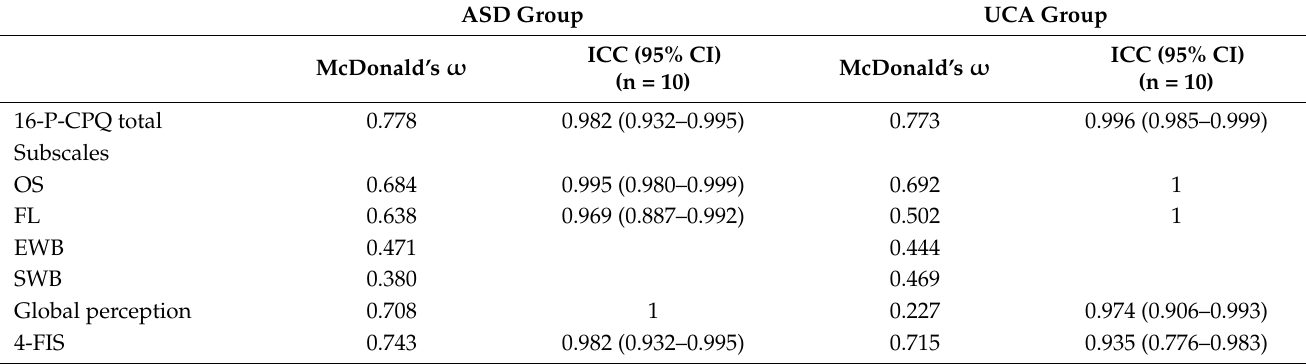
Table 4. Scale reliability statistics for the 16-P-CPQ total and subscales, for the 4-FIS and global